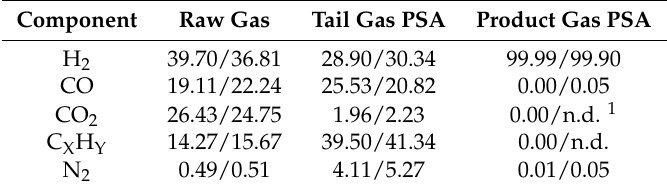
Table 2. Measured raw data in comparison to the validated data at the different measurement points in vol-% (validated data/raw